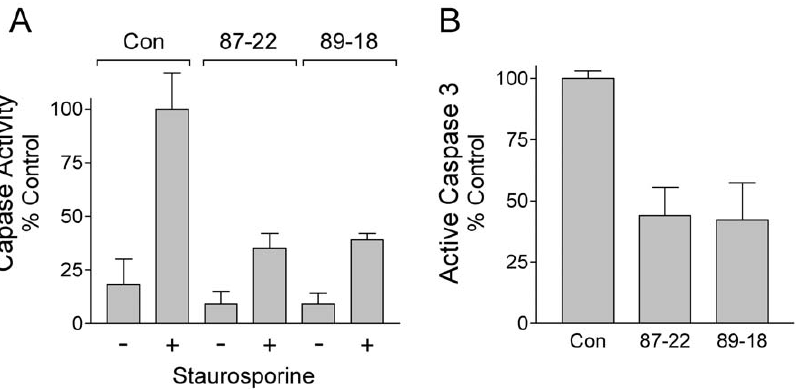
Figure 7. Timeless-knockdown EBs are resistant to apoptosis. A , Control and Tim-knockdown EBs were grown for 6 days from the corresponding ES cell lines and incubated in the presence or absence of 0.5 m M staurosporine for 16 h. Cell lysates were analyzed for Caspase 3/7 activity using the Apo-1 assay. The data are normalized to the activity observed with control EBs in the presence of staurosporine. The experiment was repeated three times, and the results are presented in the bargraph as mean percent of control 6 S.E.M. B , Lysates from staurosporine-treated control and Tim-knockdown EBs were analyzed for the presence of the active form of Capsase-3 by immunoblotting with an antibody specific for the cleaved, active form of this protease. Signal intensities were quantified using the LI-COR Odyssey system, and normalized to control values. The experiment was repeated in triplicate, and the bargraph shows the mean values 6 S.E.M. EBs derived from both Tim knockdown cell lines showed a significantly reduced apoptotic response to staurosporine treatment in each of these assays (p # 0.02 in each